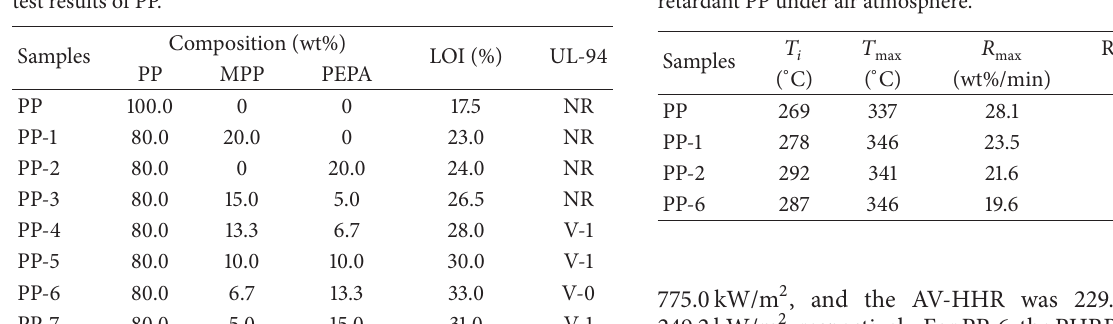
Table 2: Effect of MPP and PEPA content on the LOI and UL-94 test results of PP.